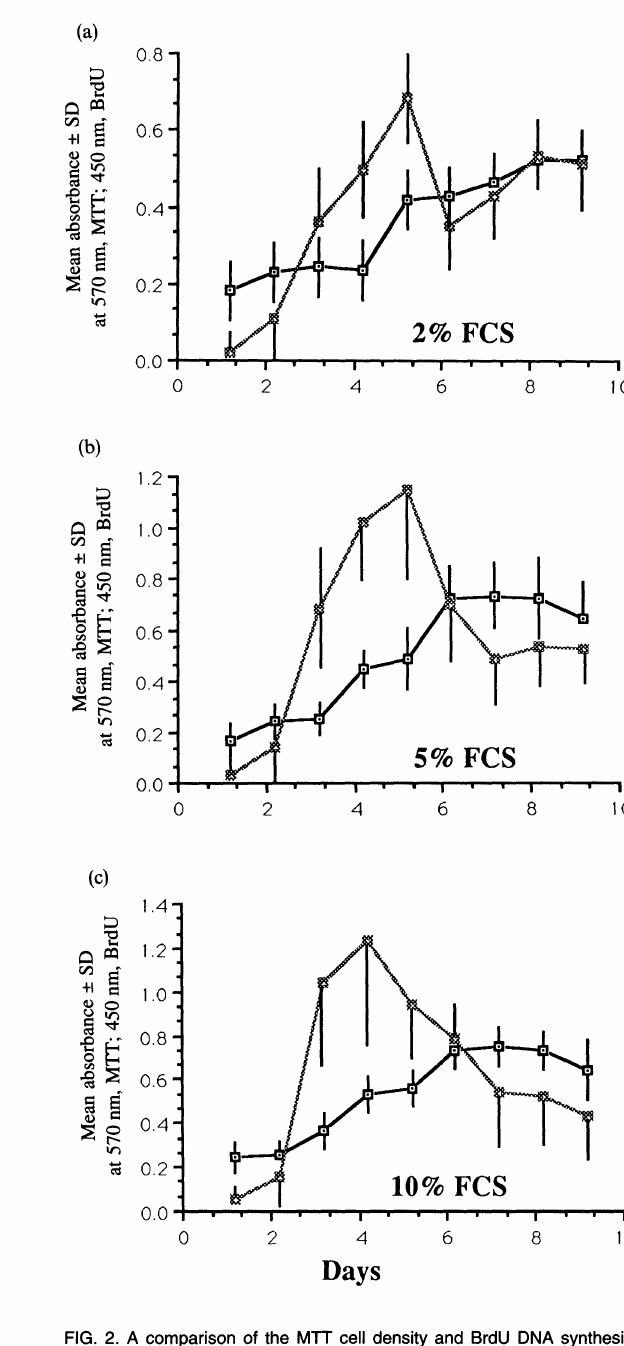
FIG. 2. A comparison of the MTT cell density and BrdU DNA synthesis assays using 1407 epithelial cell line over time and different concentrations of foetal calf serum in the culture medium. The assays were carried out in parallel at the same time. The cells reach maximum density (confluence) towards days 7 and 8. However, peak DNA synthesis occurs during the log phase of growth on days 4-5 when most of the cells are in S phase of the cell cycle.I-T I, MTT assay; D, BrdU